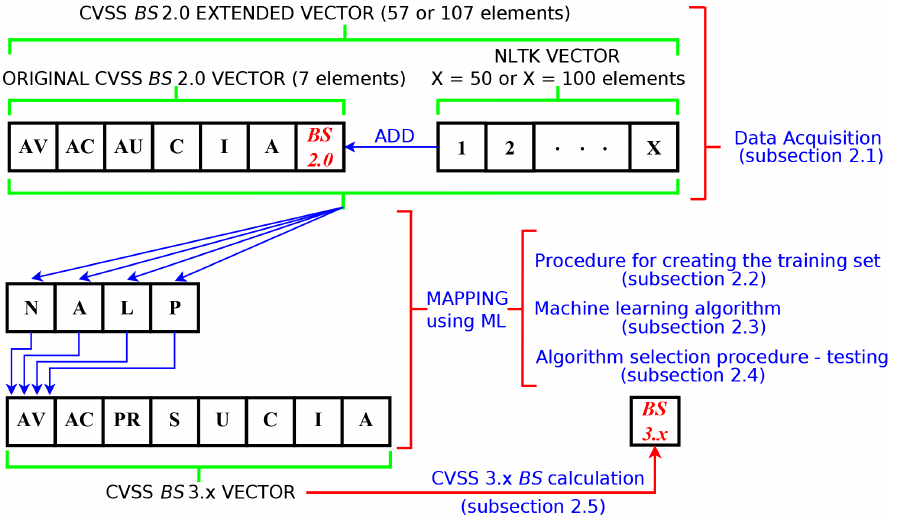
Figure 1. Schematic diagram showing the mapping of the CVSS 2.0 extended vectors onto classes of the AV component of the CVSS 3.x BS